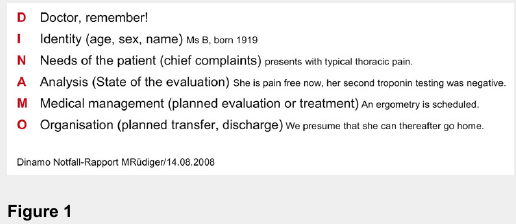
Six item mnemonic checklist (dINAMO) used in the intervention. Aim of the checklist was to make the reporting physician concentrate on relevant information with brevity and on the other hand give listeners an opportunity to check if all necessary items had been handed over.